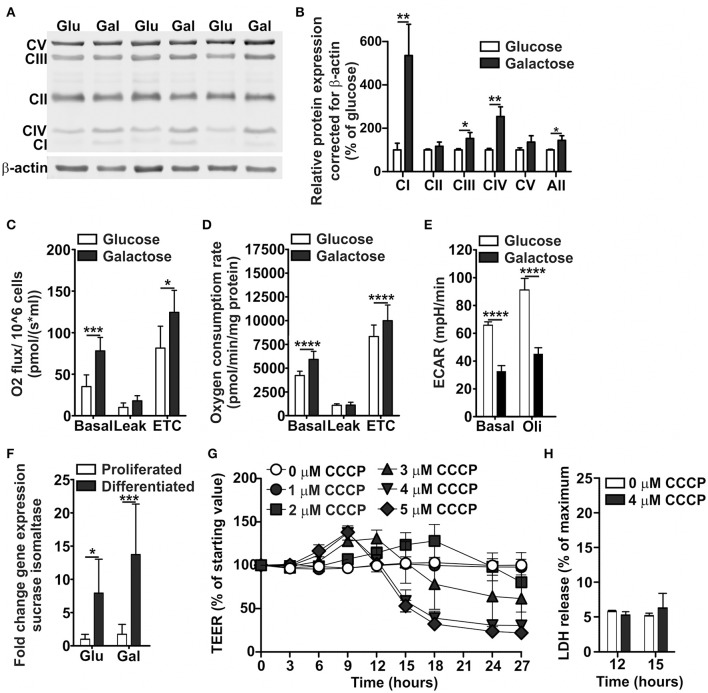
Oxidative metabolic characterization of Caco-2 cells proliferated and differentiated in glucose- and galactose-containing medium. Caco-2 cells were proliferated in DMEM-glucose or DMEM-galactose for 10 days, after which (A,B) levels of OXPHOS complexes, and (C) basal, leak, and maximal (electron transport chain, ETC) oxygen consumption rates were determined. Caco-2 monolayers were semi-differentiated in DMEM-glucose and DMEM-galactose for 14 days after which (D) basal, leak, and maximal oxygen consumption rates and (E) basal and oligomycin (Oli)-induced ECAR values were determined. 14-days differentiated Caco-2 monolayers grown in DMEM-glucose and DMEM-galactose were tested for (F) their sucrase-isomaltase gene expression; Gene expression was normalized with the mRNA gene expression of β-actin and β-2 microglobulin. The 14-days differentiated Caco-2 monolayers using DMEM-galactose were incubated with CCCP (0-1-2-3-4-5 μM) after which (G) the transepithelial electrical resistance (TEER) and (H) the cytotoxicity, as assessed by the release of lactate dehydrogenase (LDH), were followed over time. The results are expressed as a mean ± SD. The * symbol indicates statistical significance of P < 0.05, **P < 0.01, ***P < 0.001, and ****P < 0.0001.